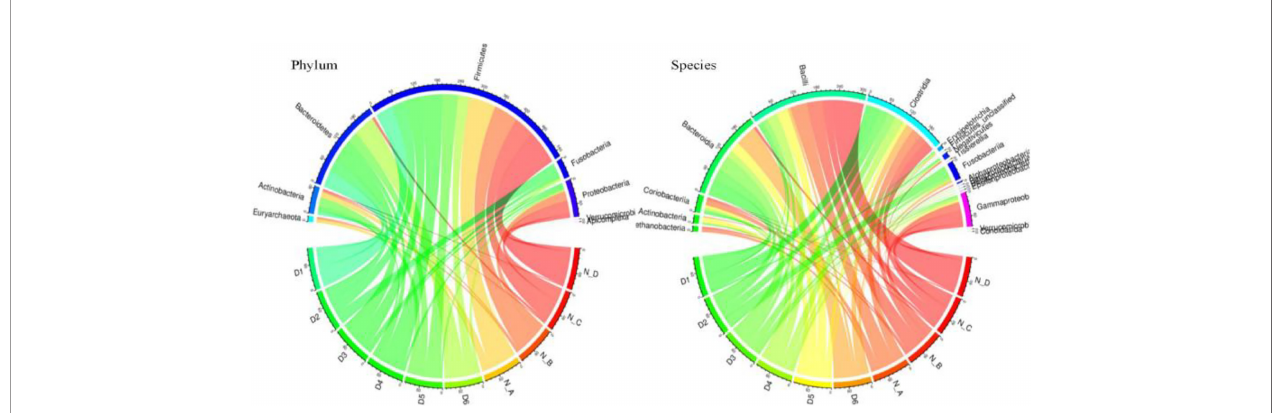
FIGURE 5 | The relationship map of circus related to yaks' different